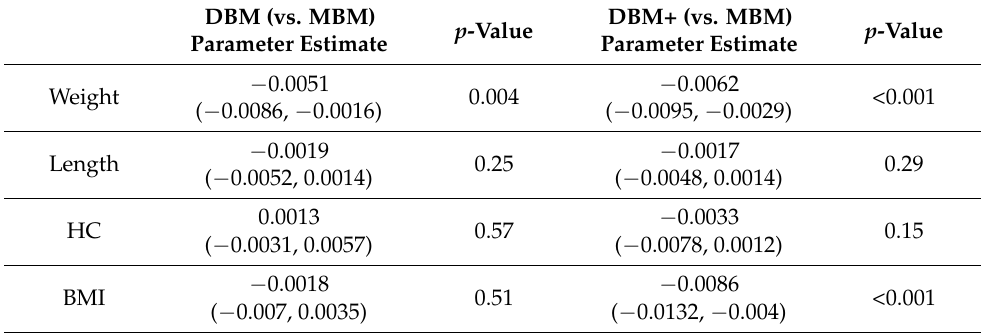
Fenton z-scores for weight, length, and HC and Olsen z-score for BMI. Generalized linear model with max- imum likelihood estimation (95% confidence interval). Growth z-scores were the outcomes, and the vari-